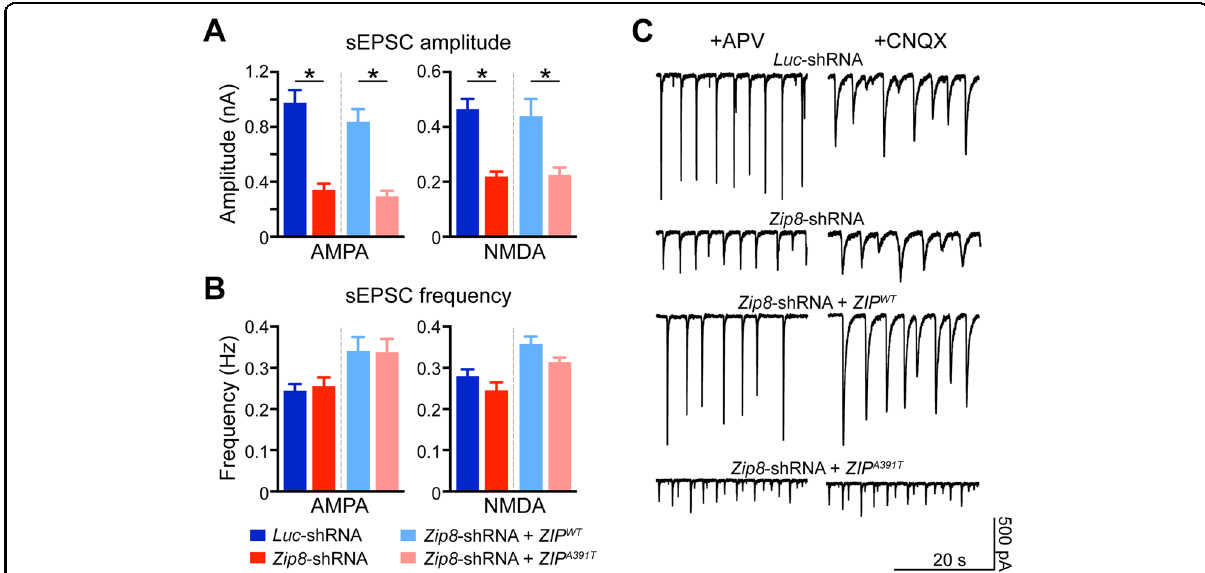
Fig. 2 ZIP8 total knockout (KO) and loss-of-function allele A391T displays neuronal activity-dependent de fi cits in glutamate receptor- mediated sEPSCs. A , B Quanti fi cation of sEPSC amplitude ( A ) and frequency ( B ) recorded from cultured D28-30 neurons. * P < 0.05 (Student ’ s t -test, n = 6 – 10 per group). Error bars, SEM. C Representative raw traces of glutamate receptor-mediated sEPSCs in cultured pyramidal neurons expressing either Luc -shRNA, Zip8 -shRNA, Zip8 -shRNA + ZIP8 WT plasmid, or Zip8- shRNA + ZIP8 A391T plasmid. Note the signi fi cant loss of sEPSC amplitude, not frequency, in the presence of the ZIP8 A391T mutation, consistent with the loss-of-function observed in Fig. 1. No changes were observed in